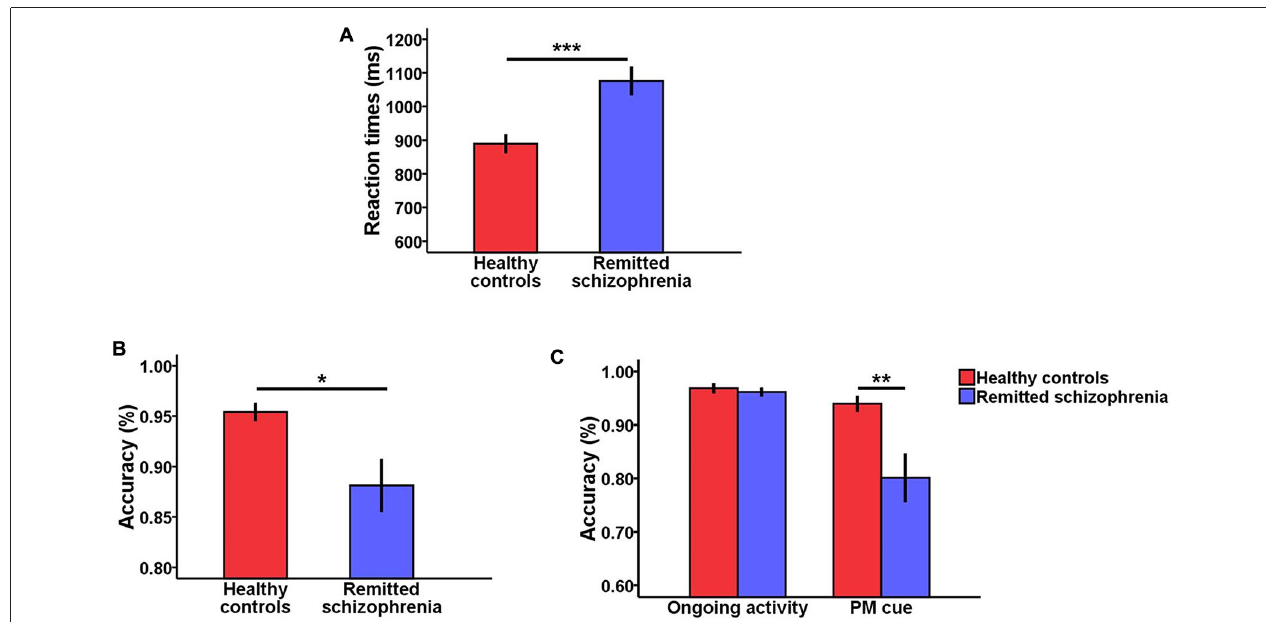
FIGURE 1 | Behavioral results. (A) Bar plots of response times according to group (symptomatically remitted patients with schizophrenia vs. healthy controls). (B) Bar plots of accuracy according to group (symptomatically remitted patients with schizophrenia vs. healthy controls). (C) Bar plots of group × task type interaction effects on accuracy. Error bars indicate standard error of mean (SEM), ( ∗ p < 0.05, ∗∗ p < 0.01, ∗∗∗ p <